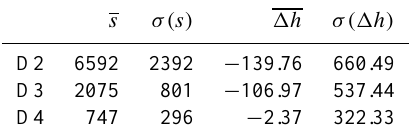
Table 3. Representativity error in different model domains. The mean and standard deviation of the horizontal distance s between the station and the closest grid point and the height difference be- tween both (cid:49)h (both in metres) are shown for domains D2 to D4. The values are calculated considering all stations shown in Fig.